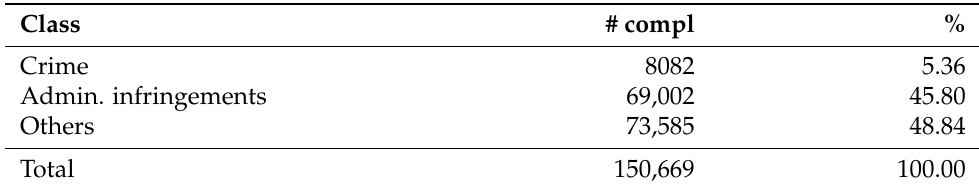
Table 2. Infraction severity class distribution.